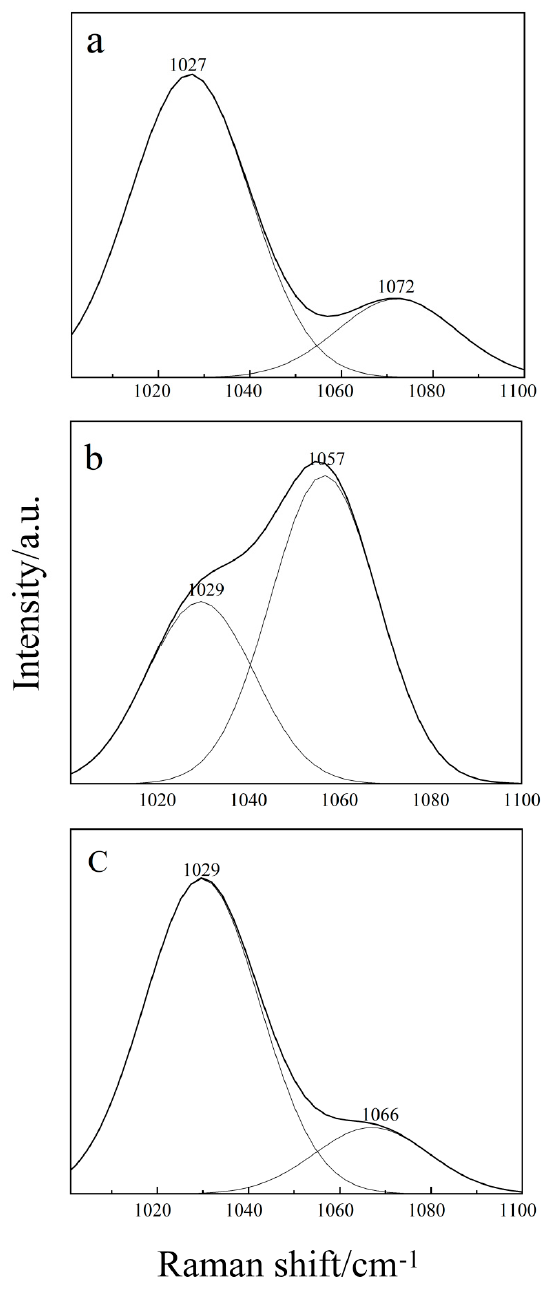
Figure 3. Raman shift vs. hydrogen bonding between different solutions. ( a ) pure THF, ( b ) THF–DMSO solution, and ( c ) H 2 O-THF.